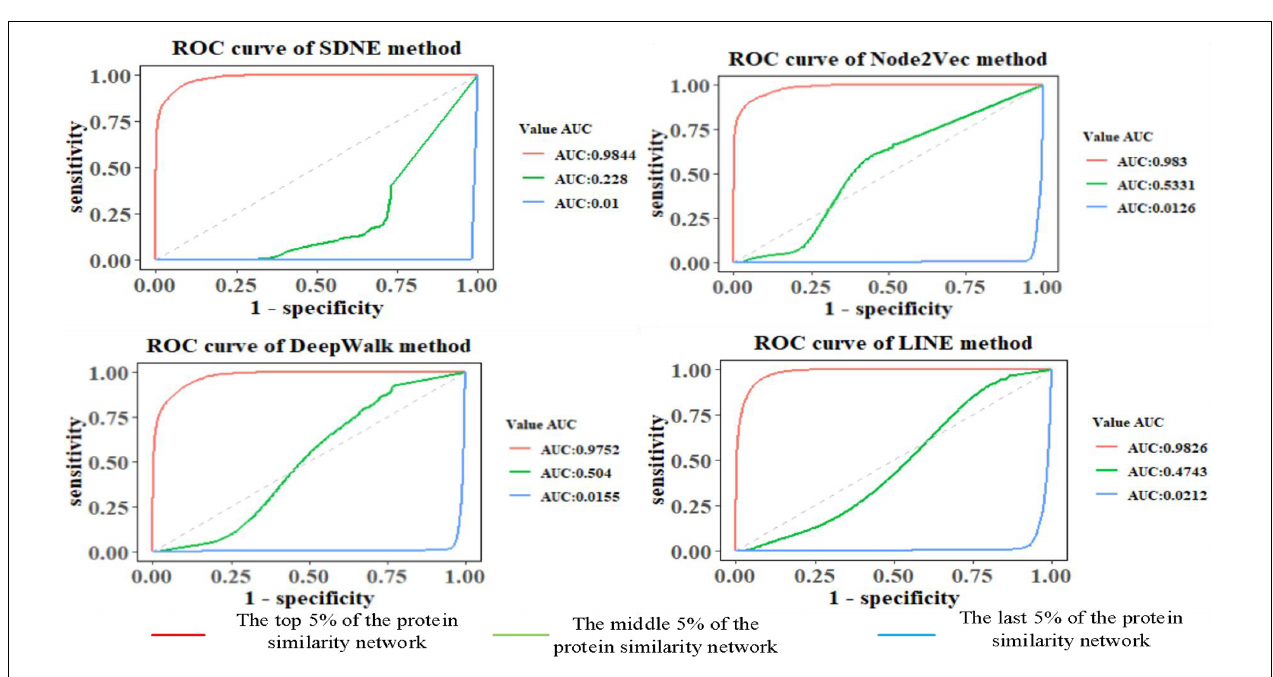
FIGURE 4 | Comparison of prediction results of Human protein similarity networks.